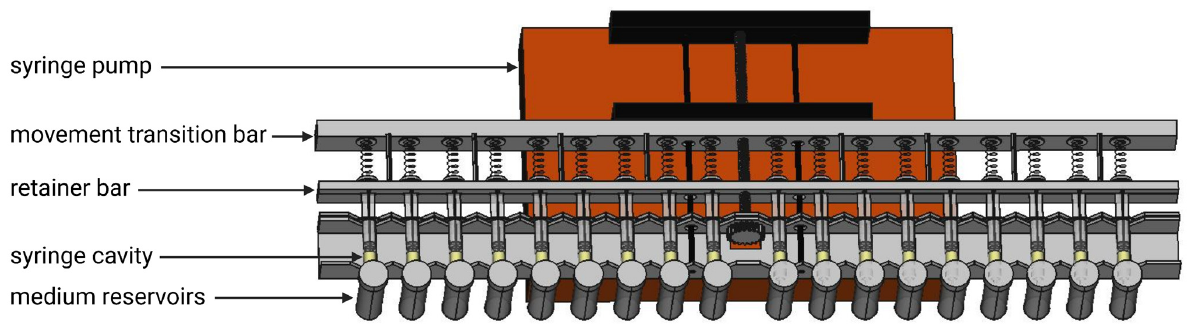
Figure 2. Schematic top view on the in vitro model.